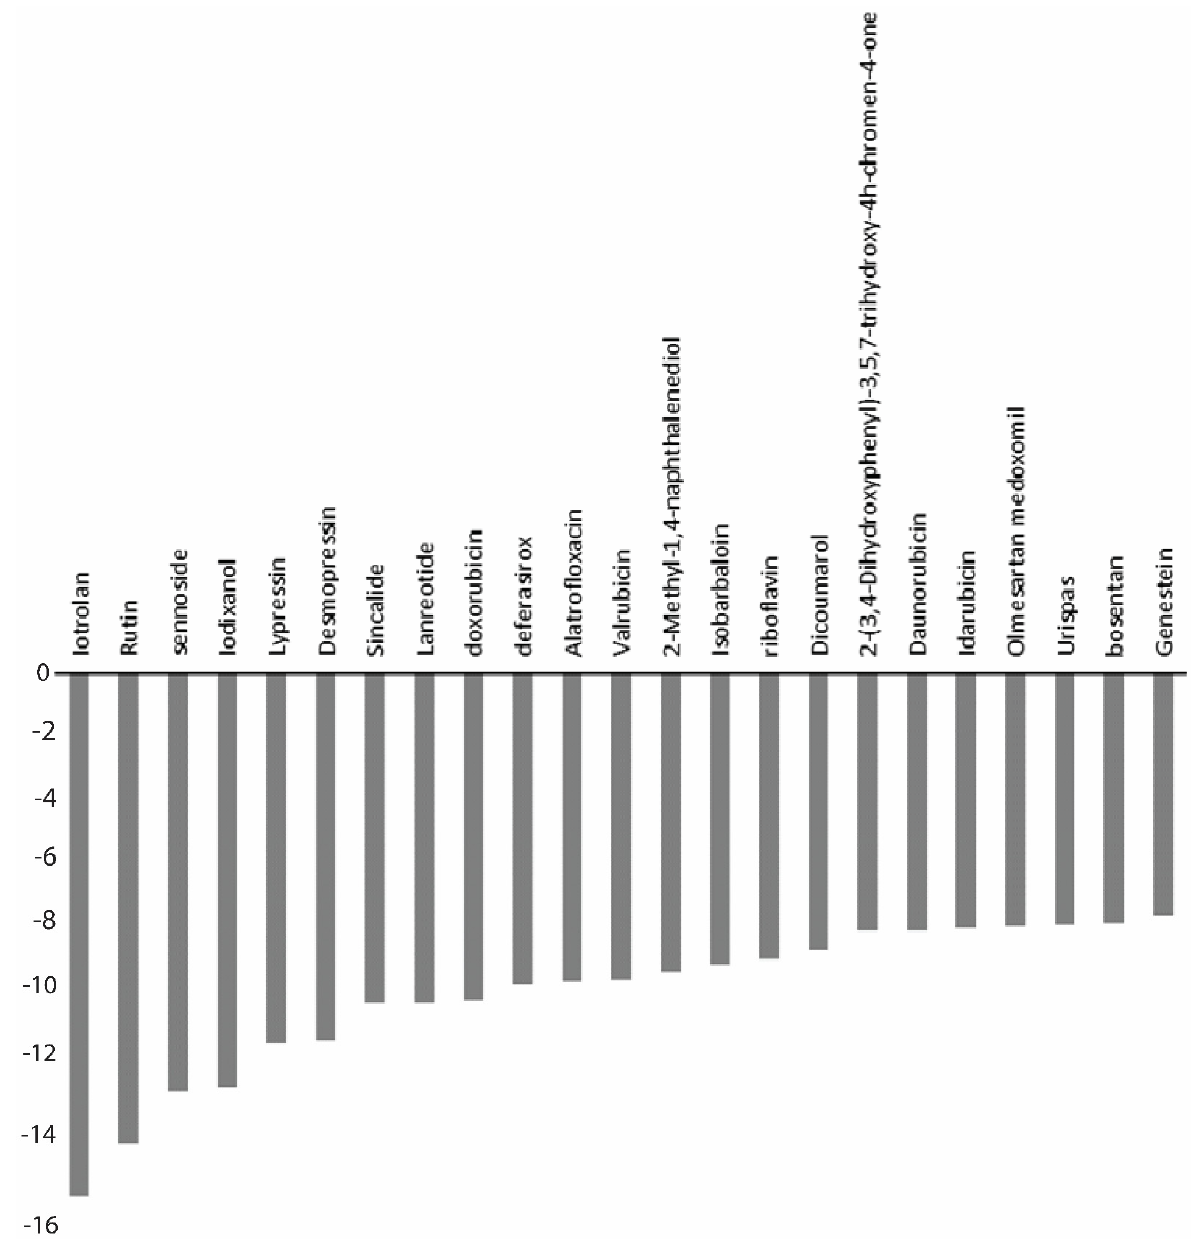
Figure 2. XP scores of 23 compounds selected after SP and XP structure-based screening using Glide (Schrödinger Release 2018-3: Glide, Schrödinger, LLC, New York, NY, USA, 2018). Desmopressin, rutin, lypressin and lanreotide showed − 10.57, − 13.43, − 9.84,